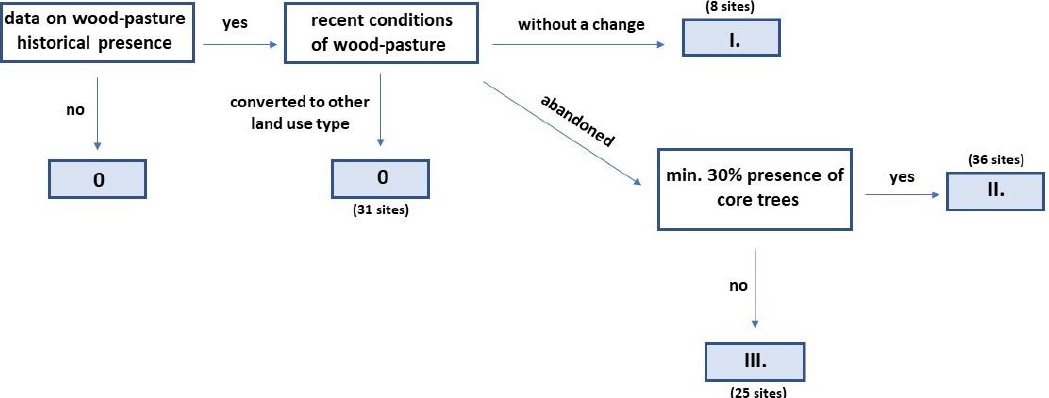
Figure 6. Decision tree classifier based on the potential for restoration of historical wood pasture. The potential for restoration decreases from the category I to III, and 0 refers to zero potential. Numbers in brackets represent the number of localities within each category identified in our